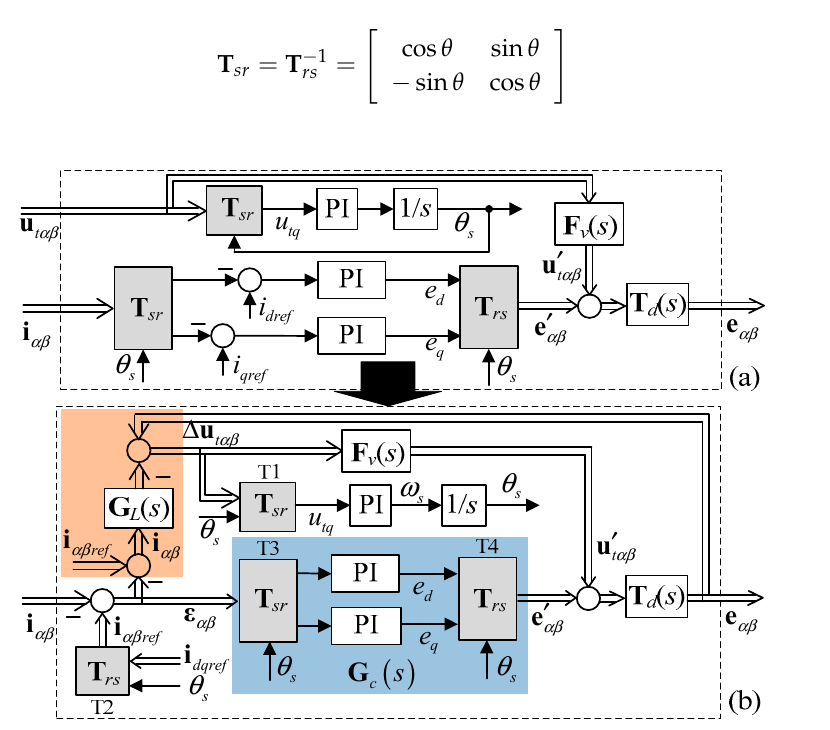
Figure 3. The process to obtain the current-balancing driven internal voltage motion model, ( a ) the basic control diagram of the VSC; and ( b ) the VSC model without input of the terminal voltage. In Figure 3, the PIs are the proportional-integral regulators for current control and